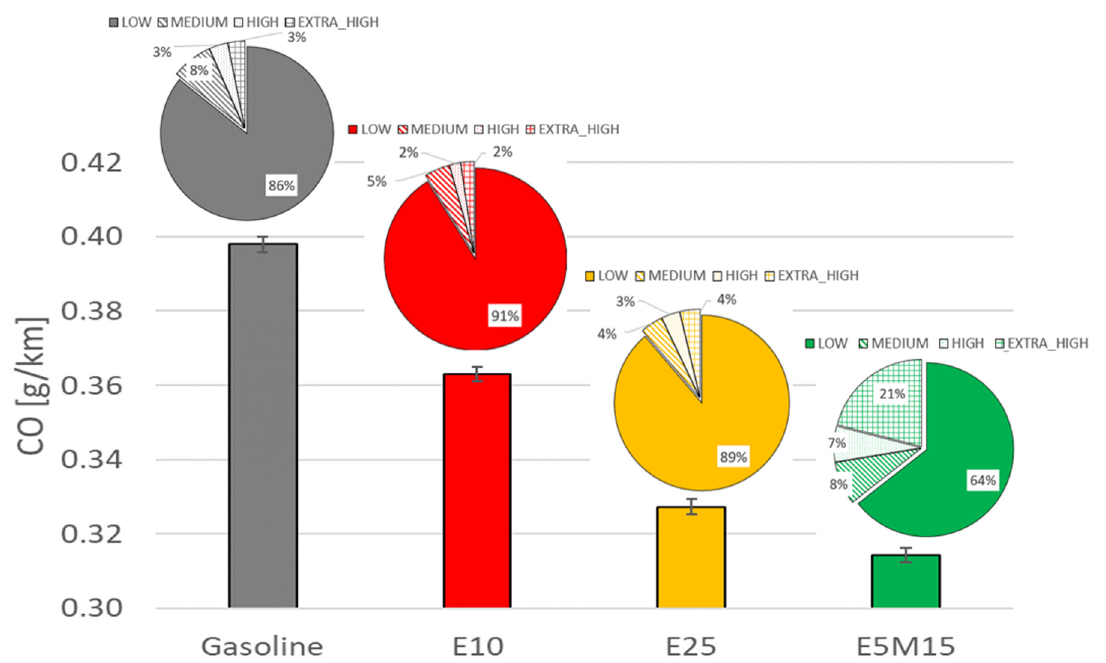
Figure 6. CO emissions measured at each phase of the cycle for gasoline, E10, E25 and E5M15.